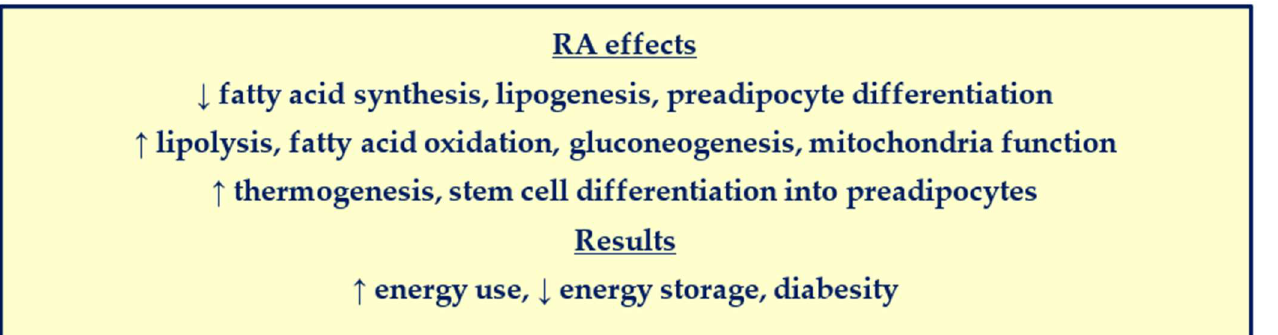
Figure 4. RA regulation of energy balance . Although RA supports pancreatic β cell development and maintenance, it also counters insulin actions, and thereby restricts diabesity. Arrows indicate increases or decreases.